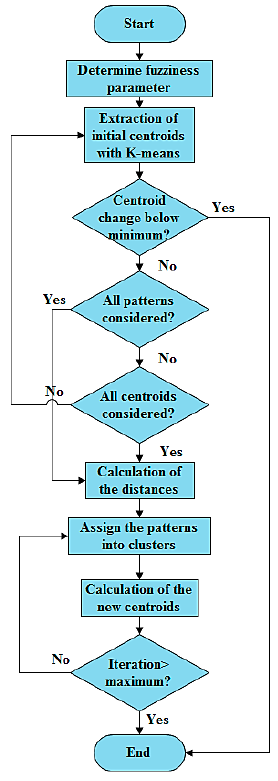
Figure 3. Flowchart of the improved FCM algorithm.